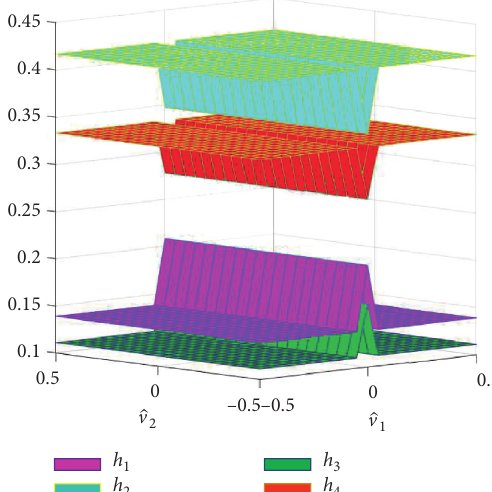
Figure 6: Weighting functions for the four fuzzy sets